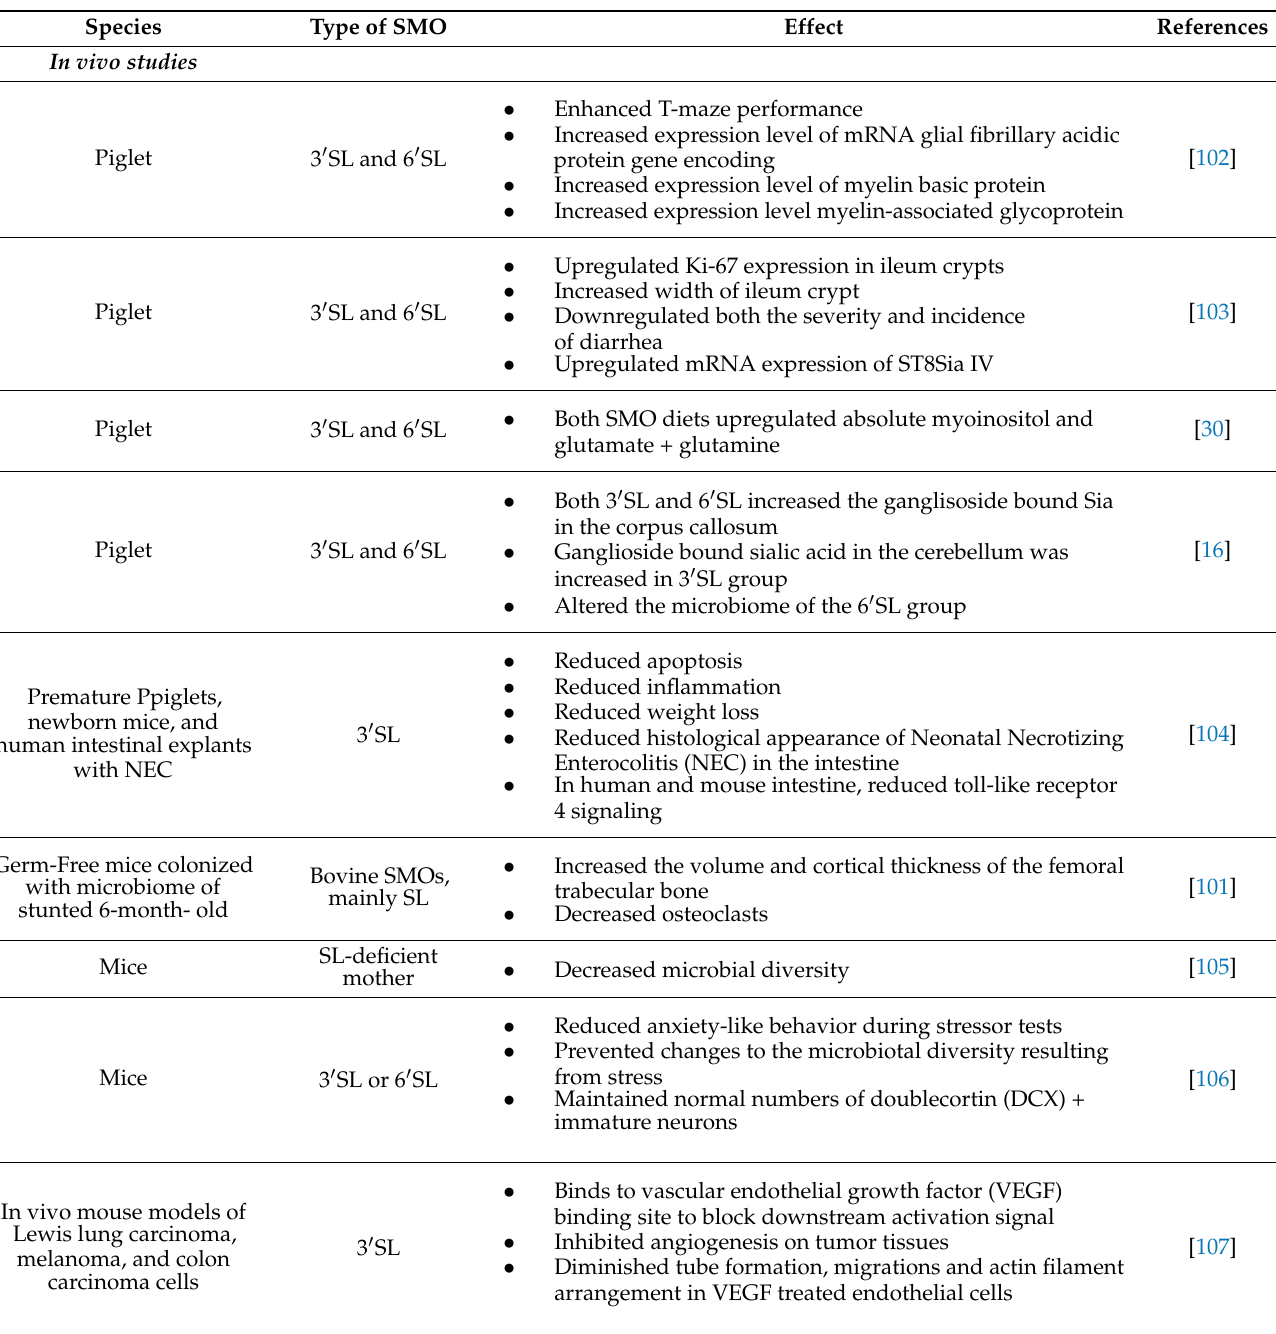
Table 3. Summary of in vivo and vitro studies documenting the beneficial impacts of sialylated milk oligosaccharides (SMOs).